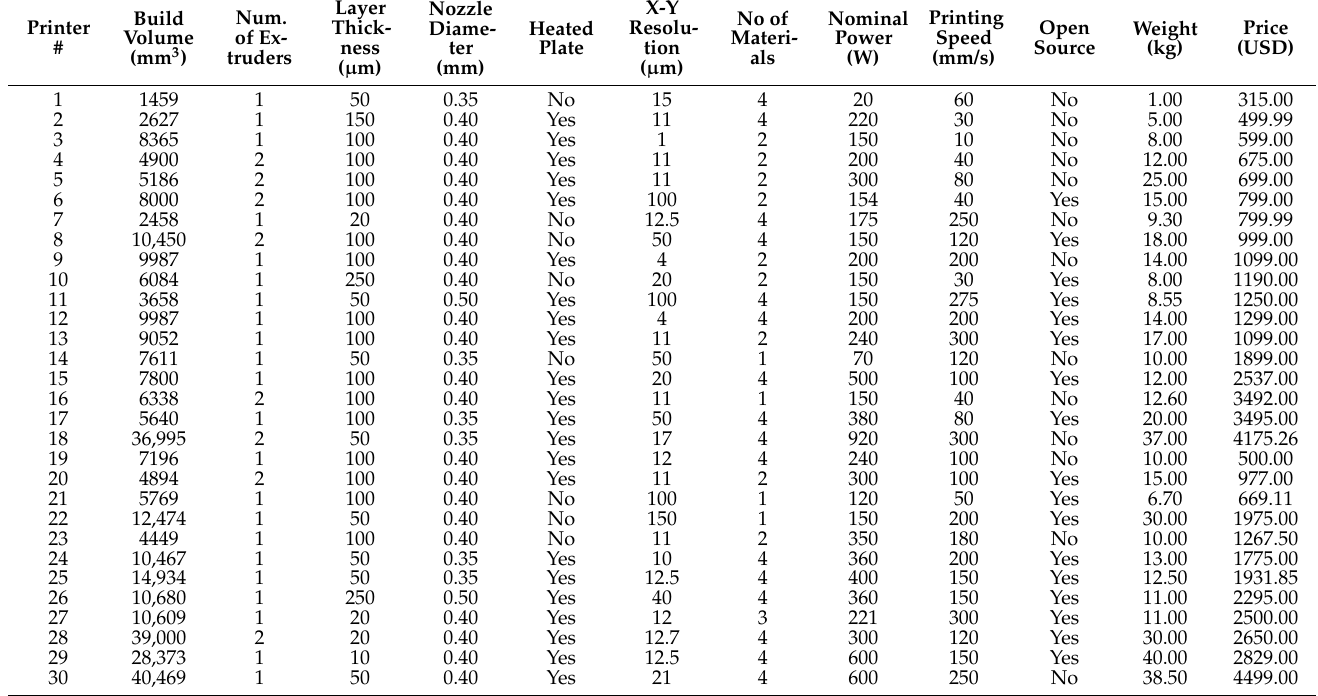
Table 2. Technical specifications/parameters (outputs) and price (input) of the 3D printers